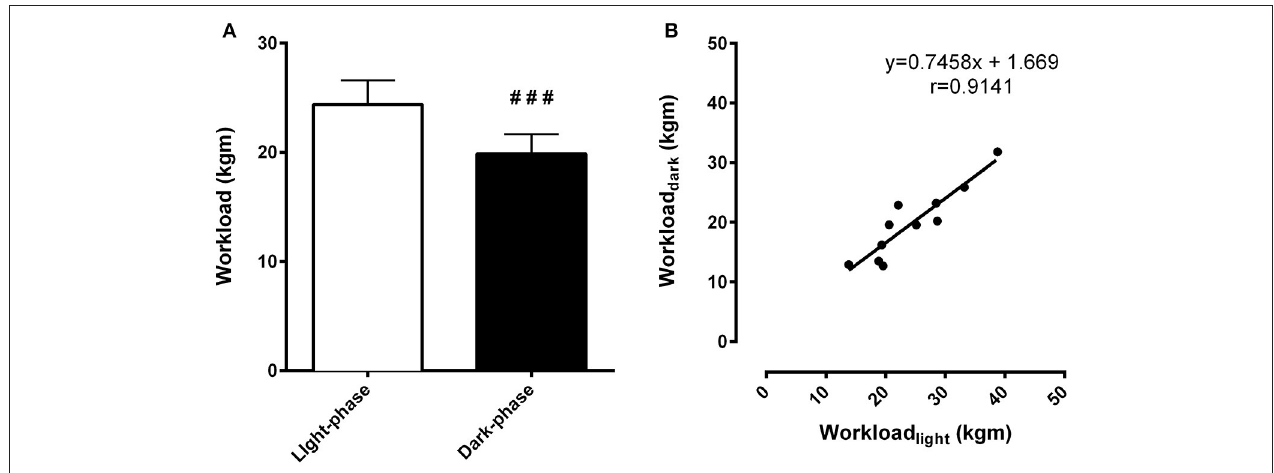
FIGURE 2 | Differences in exercise capacity during the light and dark-phases are independent of the variability of individual performance. In (A) , total workload (kgm) is an index of exercise capacity. In (B) , correlation analysis between light and dark-phase workload calculated for each animal ( n = 11) was performed to identify whether differences in exercise capacity could be related to the individual chronotype. Pearson’s r coefficient was 0.9141 and p < 0.0001. ### Indicates p < 0.001 between phases. The results are expressed as the mean ± SEM ( n = 11).